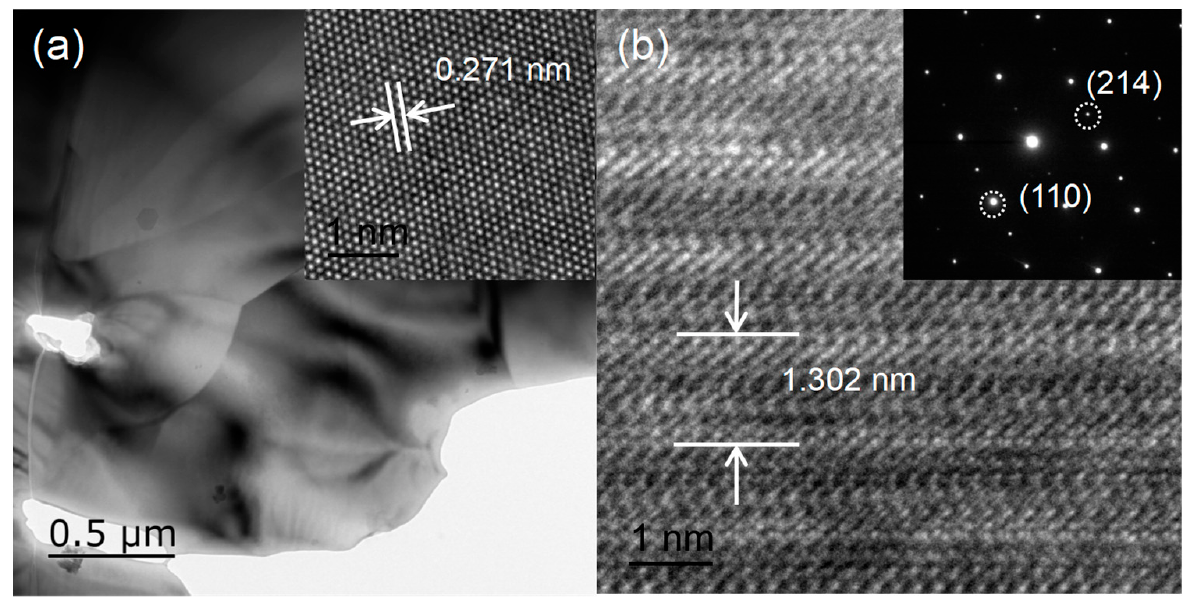
Figure 2. ( a ) TEM and ( b ) HRTEM image of Pr2FeAlO6. Inset of ( b ) shows SAED. The viewing direction is parallel to the <010> direction.